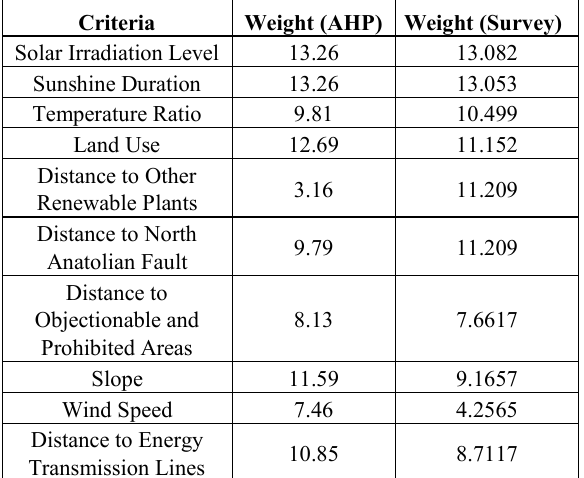
Table 5. Weights of Criteria (%) with AHP and Survey